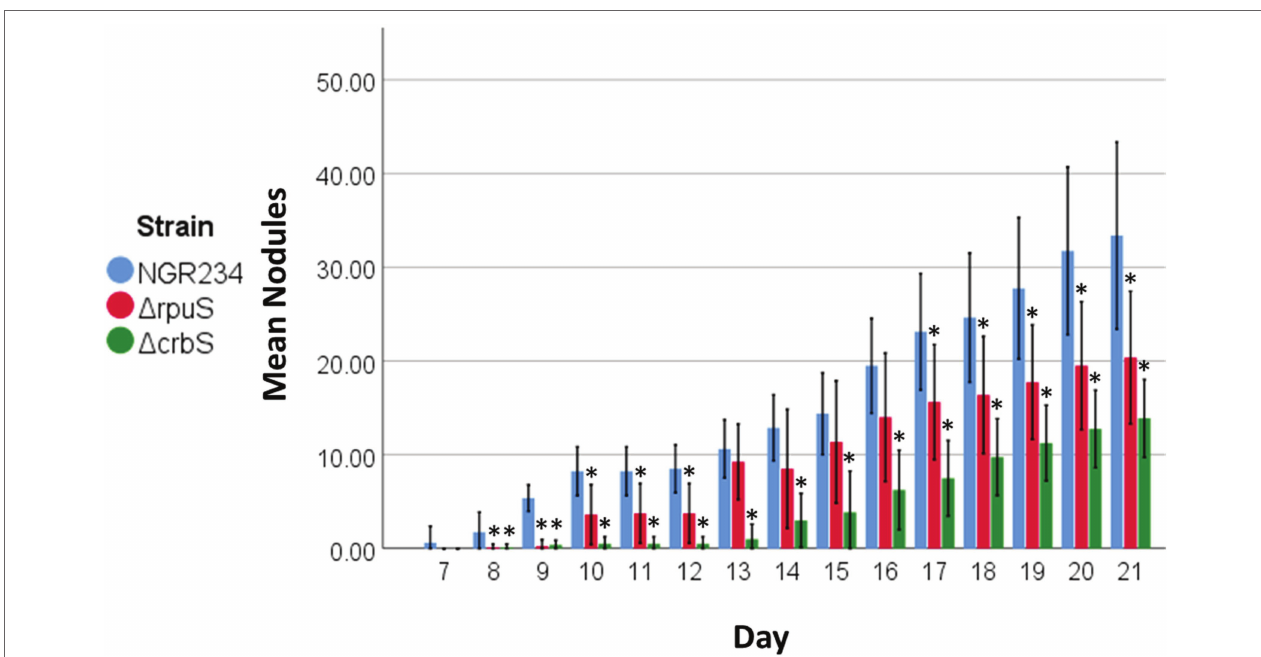
FIGURE 6 | Common bean nodulation kinetics of S. fredii NGR234 (blue) and its Δ rpuS (red) and Δ crbS (green) derivative mutant strains. Bars represent the average number of nodules per condition per day of 8 plants ± SD per condition. An asterisk over bars indicates significant differences ( p < 0.05).